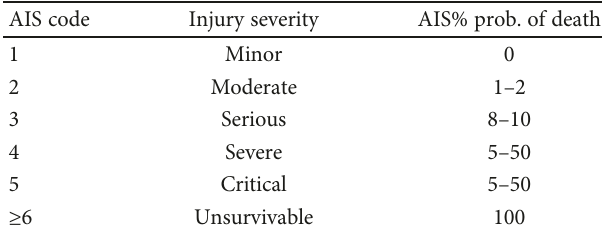
Table 1: Abbreviated injury